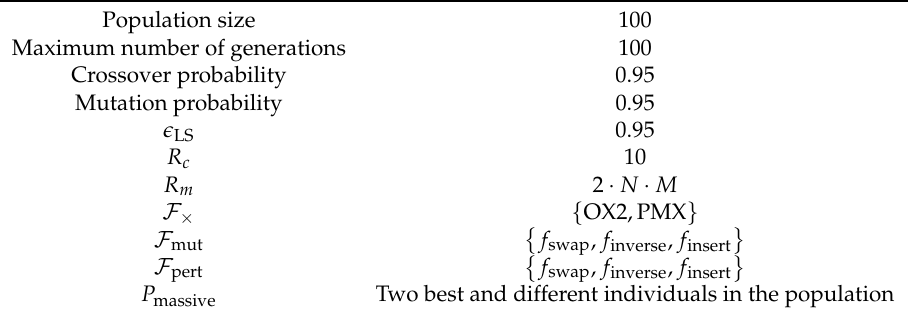
Table 4. Configuration of parameters for our Multi-Crossover Local Search Genetic Algorithm